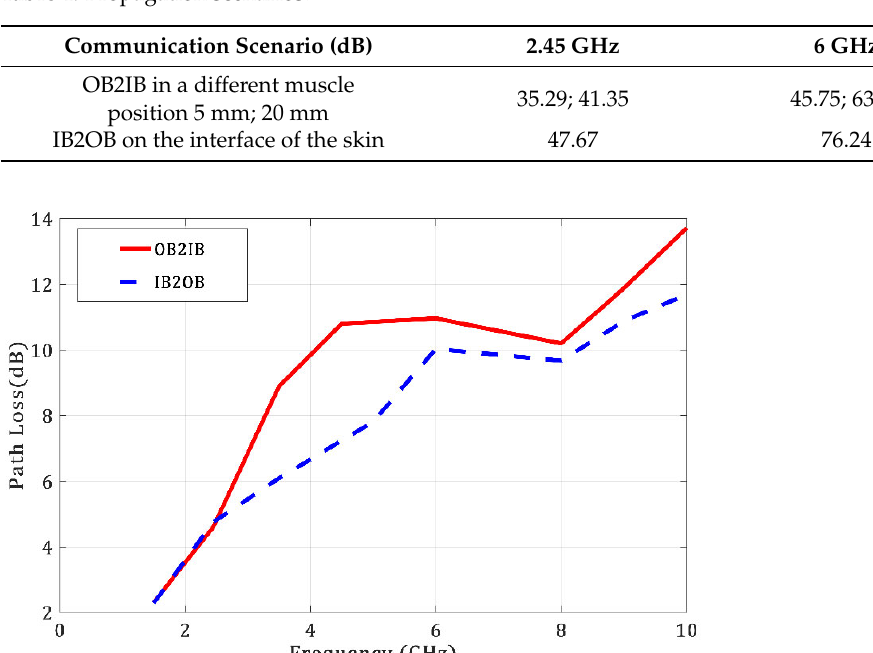
Table 4. Propagation scenarios.